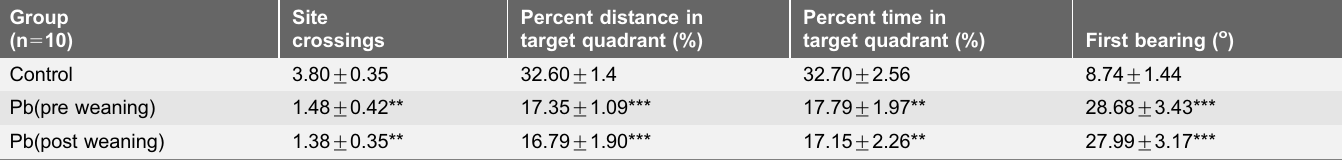
Table 6. Effect of developmental lead exposure on the performance of rat pups in the probe trial of MWM test on PND85–90. Group (n 5